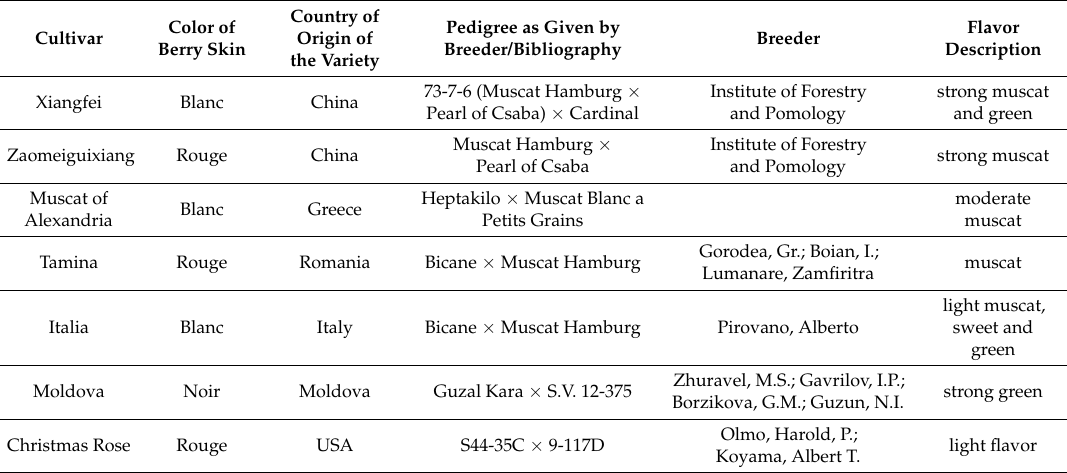
Table 3. Grape cultivars included in the